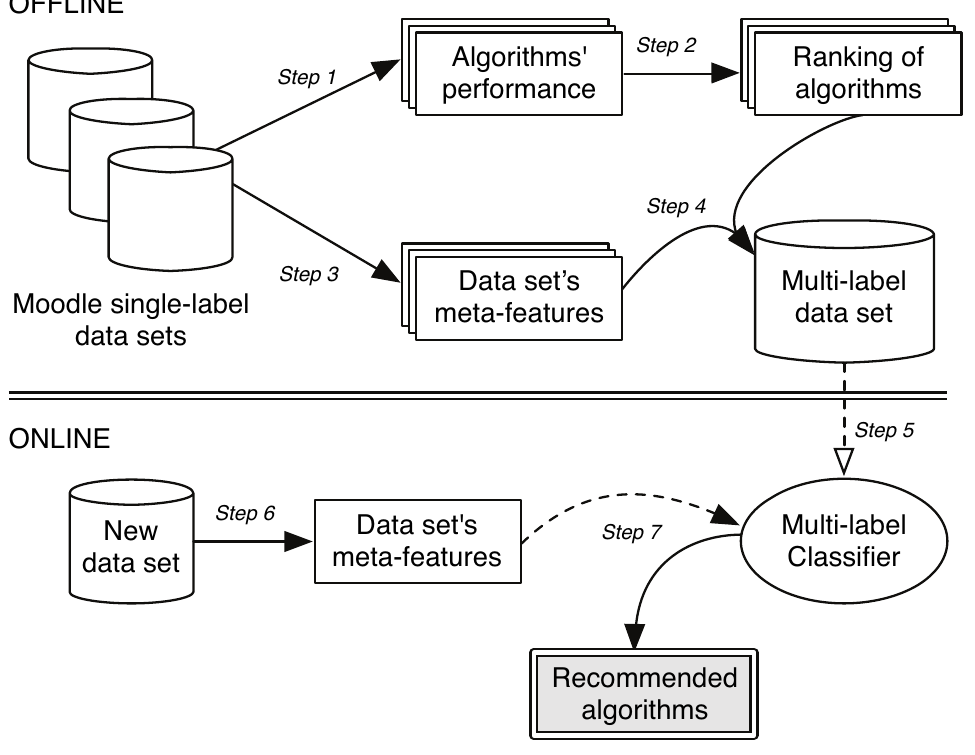
Figure 1: Multi-label meta-learning